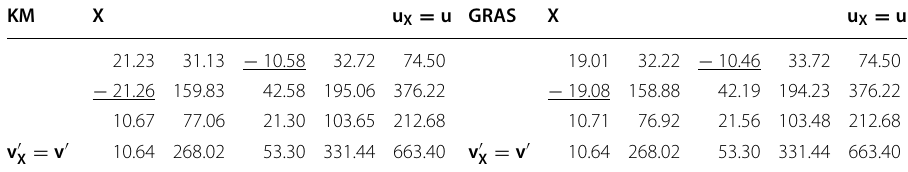
With the same location of underlined matrix elements as in Table 10